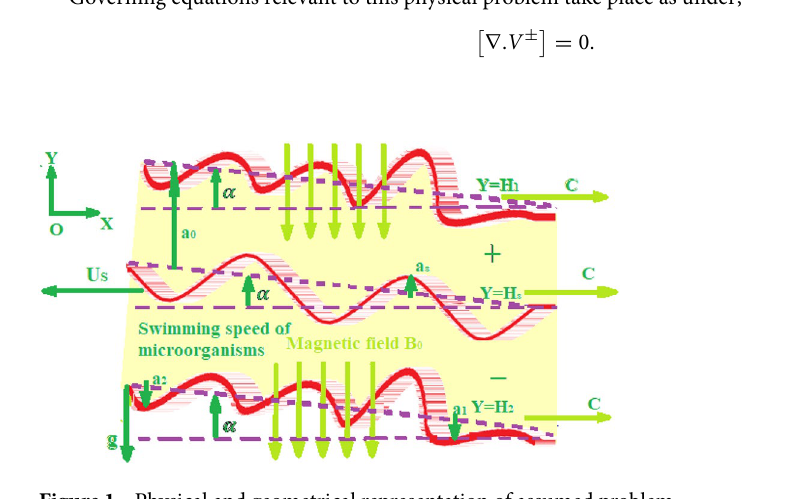
Figure 1. Physical and geometrical representation of assumed